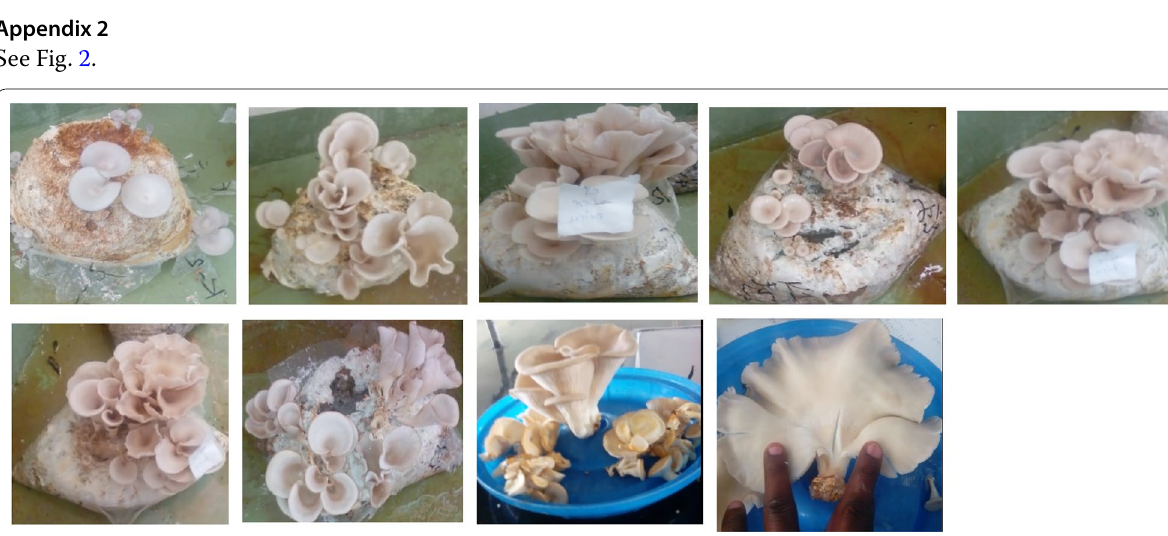
Fig. 2 Cultivated fruiting body of oyster mushroom on different substrate composition